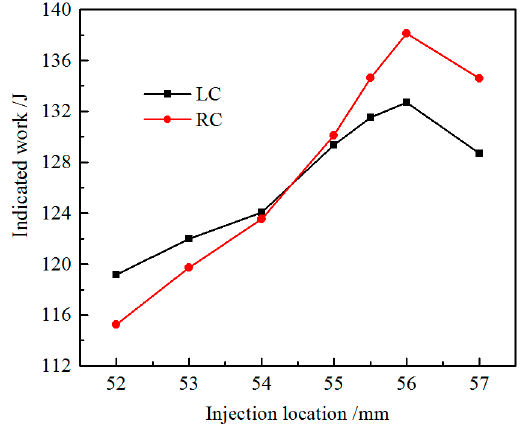
Figure 10. IW variation of the LC and the RC for different values of the “triggering position”.